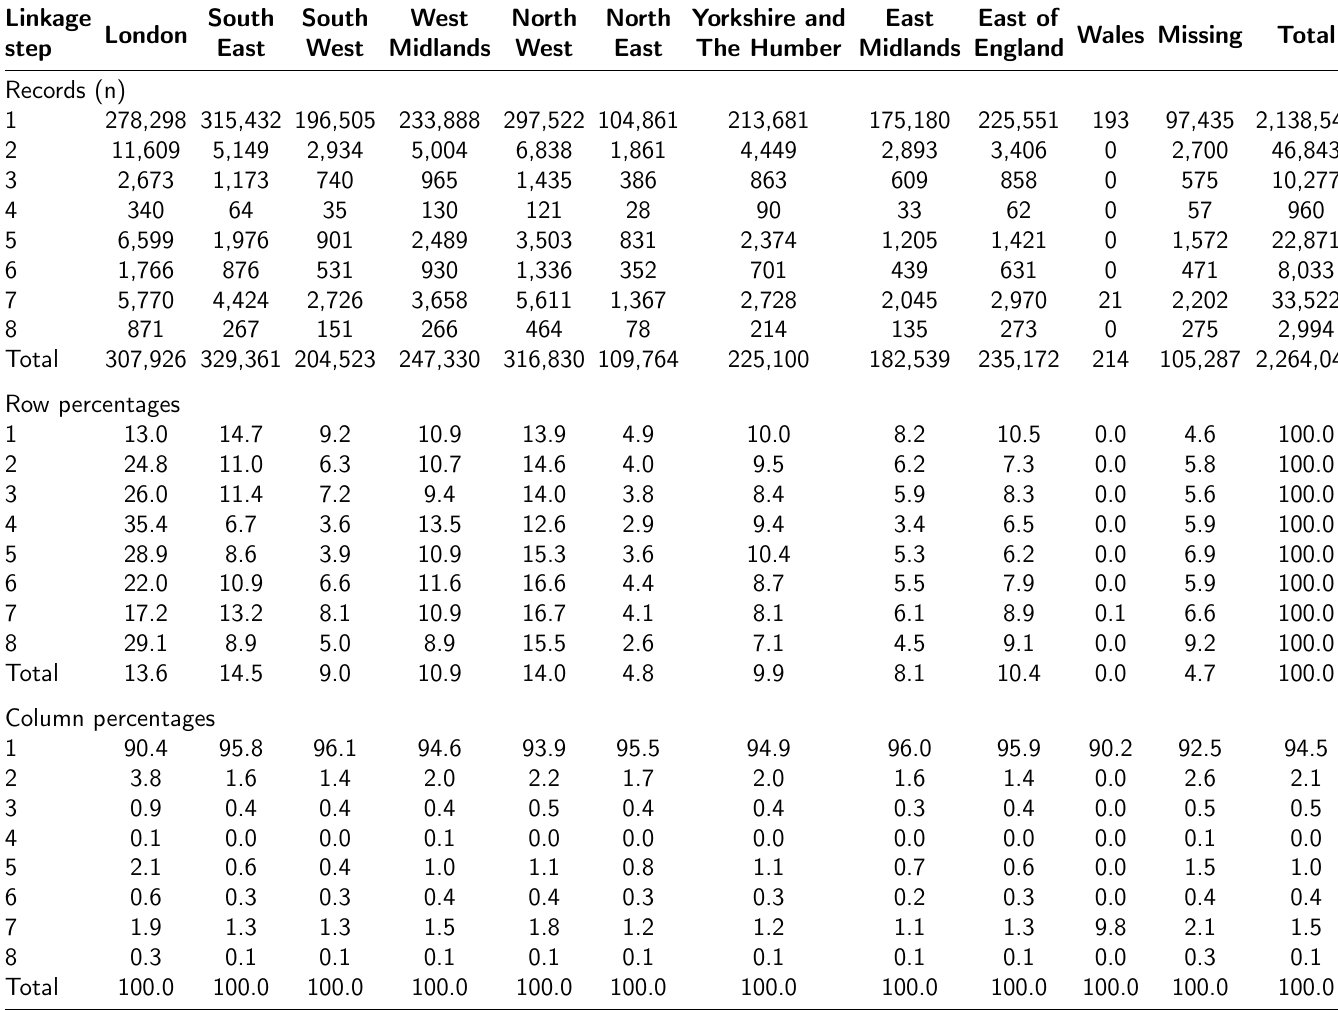
Supplementary Table 6.4: Linkage national pupil dataset to personal demographics service by linkage step and region (all